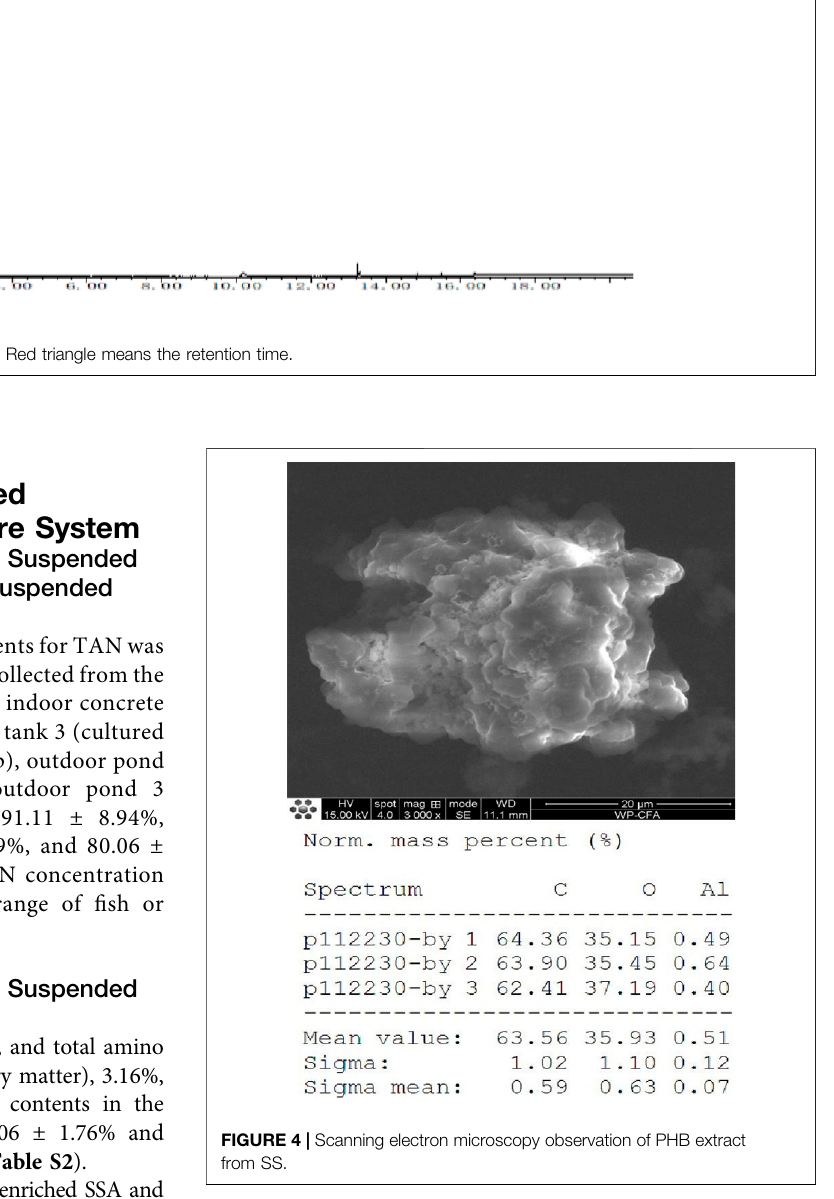
Frontiers in Physiology |